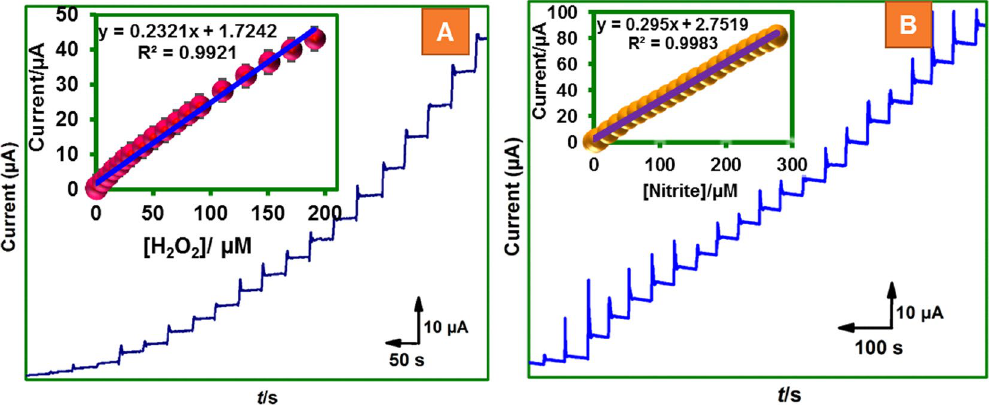
Figure 6. Amperometric response of MWCNTs@rGONRs/CHIT/Mb film modified electrode towards real samples. ( A ) H 2 O 2 detection in contact lens solution ( E app = − 0.35 V) and corresponding calibration plot (inset). ( B ) NO 2 − sensing in beef sample ( E app = + 0.70 V) and corresponding calibration plot